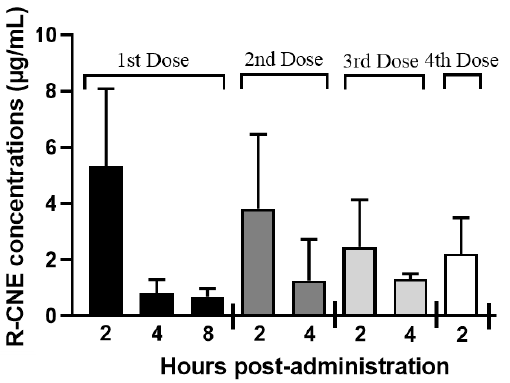
Figure 3. Mean ( ± SD) plasma carvone (R-CNE) concentrations obtained after oral administration as an emulsion (four doses of 100 mg/kg every 24 h) to lambs ( n = 6) artificially infected with susceptible H. contortus . R-CNE concentrations 2 h post treatment with the first dose were significantly higher compared to those observed at 2 h post treatment with the fourth dose ( p < 0.05). Table 2. Mean egg per gram (EPG) counts ( ± SD) and fecal egg count reduction percentage (FECR) obtained at 7 and 14 days after the oral administration of R-CNE as an emulsion (four doses of 100 mg/kg every 24 h) to lambs ( n = 6) artificially infected with susceptible H. contortus .